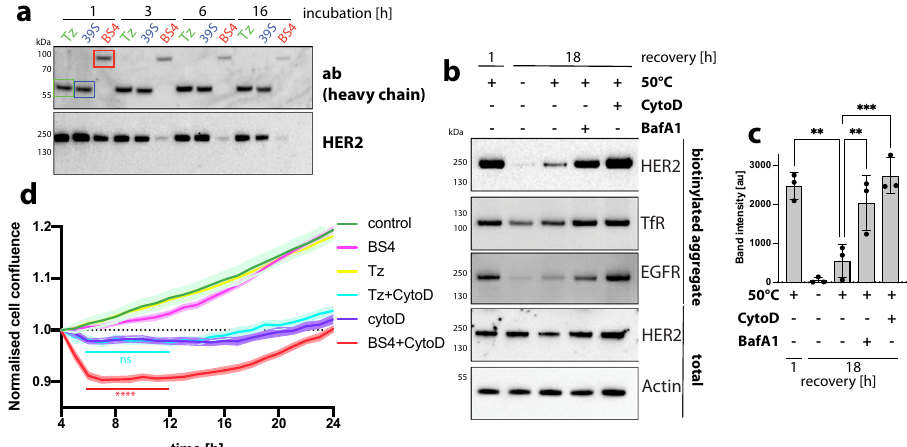
Fig. 10 | ADE facilitates lysosomal degradation of endocytosed receptor aggregates. a Time-dependent degradation of endocytosed antibody-receptor aggregates. Westernblotanalysis ofsteady-state HER2proteinand antibodylevels afterexposuretomonotopicantibodiesTzand39Saswellasbiparatopicantibody BS4 for increasing length of time. b , c Stress-induced aggregates are degraded in the lysosome after endocytosis. SkBr3 cells±CytochalasinD (CytoD) or Ba fi lomy- cinA1 (BafA1) were surface biotinylated, heat shocked for 5min (at 50°C) and subsequently incubated for the indicated length of time at 37°C. Samples were lysed in a low detergent buffer, insoluble/aggregated proteins precipitated by centrifugation, biotinylated receptors isolated as described in materials and methods and analysed by immunoblot for HER2, EGFR and TfR. Total cell lysates analysed for HER2 and actin are shown as controls. c The amount of intracellular